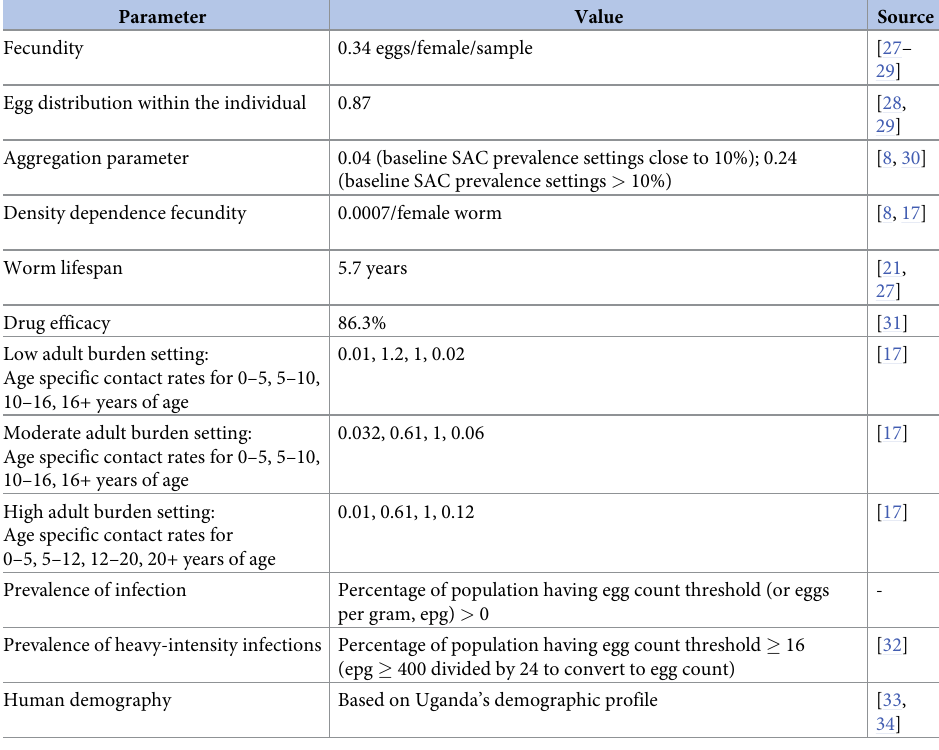
Table 1. Parameter values used within the age-structured deterministic model for Schistosoma mansoni (based on previous